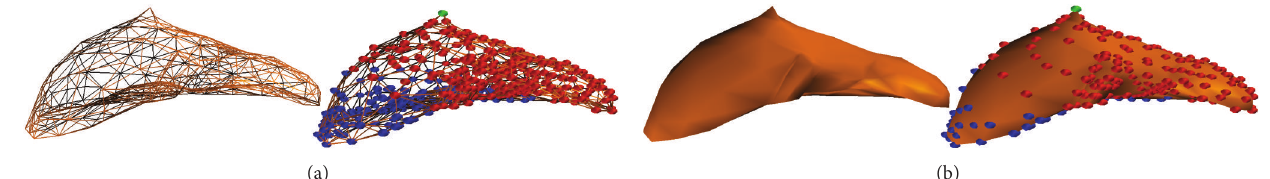
Figure 11: Nonlinear FEM results for both the proposed and Pedersen’s methods: (a) left: wireframe surface mesh; right: wireframe surface mesh with nodes; (b) left: shaded mesh; right: shaded mesh with nodes.